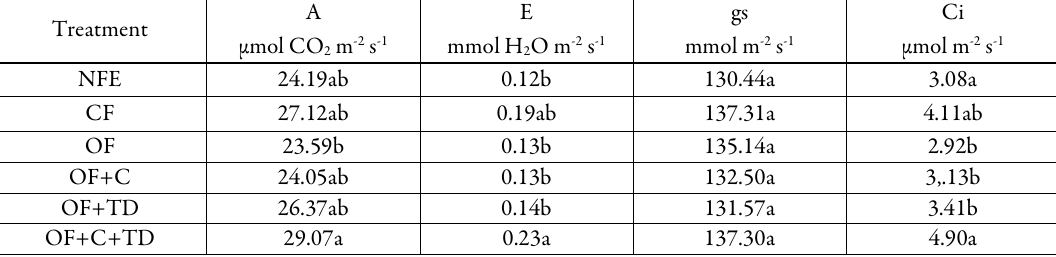
Table 4. Photosynthetic rate (A), transpiration (E), stomatal conductance (gs) and internal CO 2